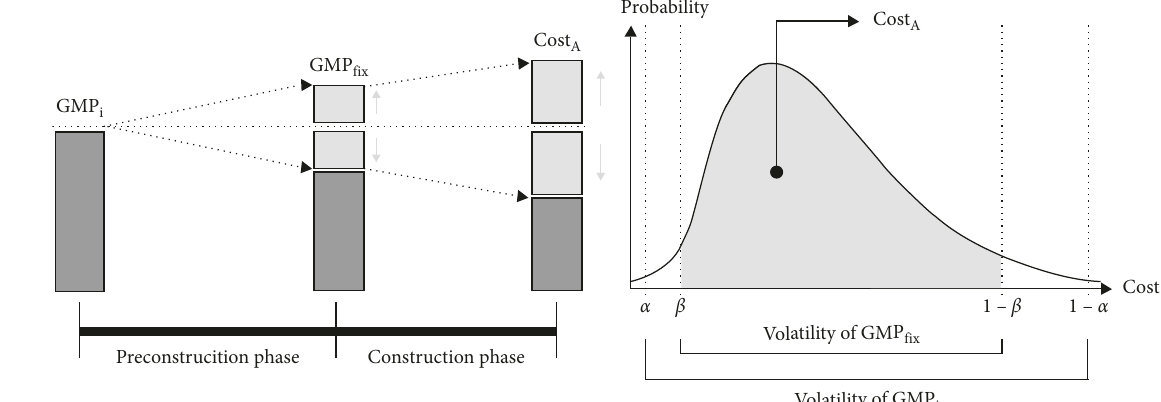
Figure 1: Uncertainty of Cost A (actual cost) in the GMP contract.